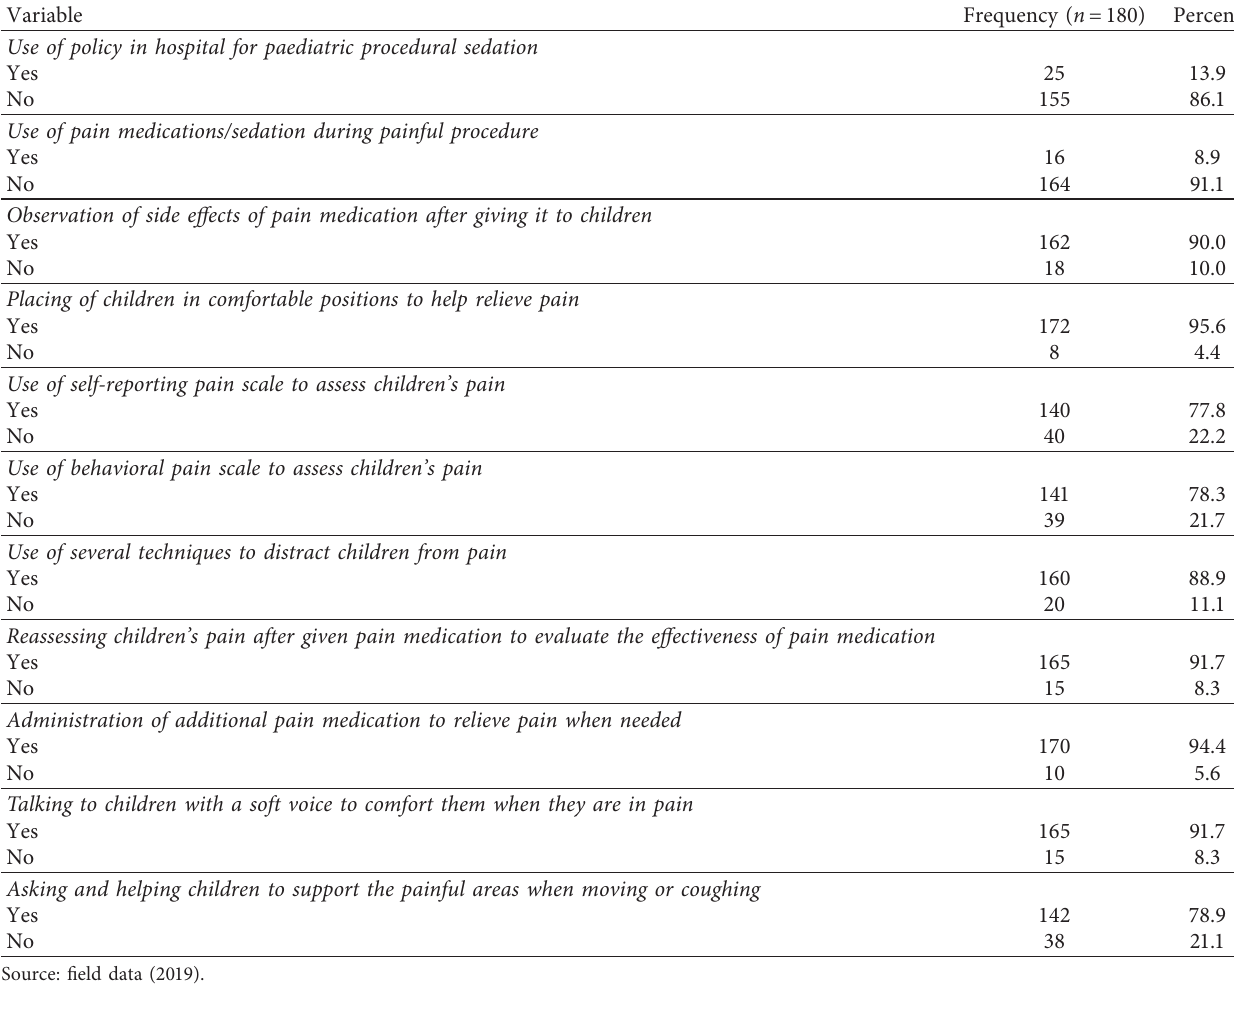
Table 4: Paediatric pain management practices.